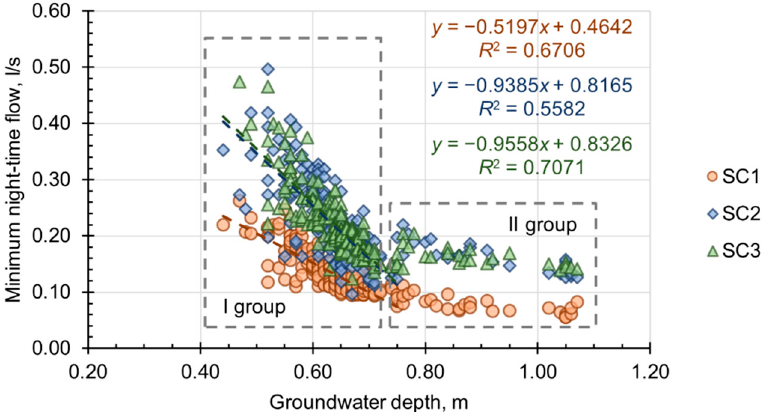
Figure 8. Scatter plots with trendlines and regression equations for SCs 1–3.